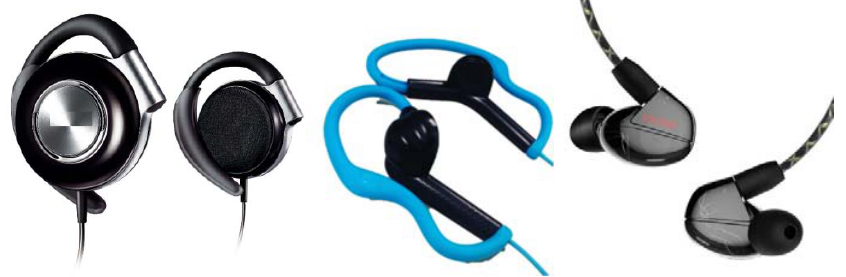
Figure 1. Three types of earphones: clip earphone ( left ), earbud earphone ( middle ), and in-ear earphone ( right ).